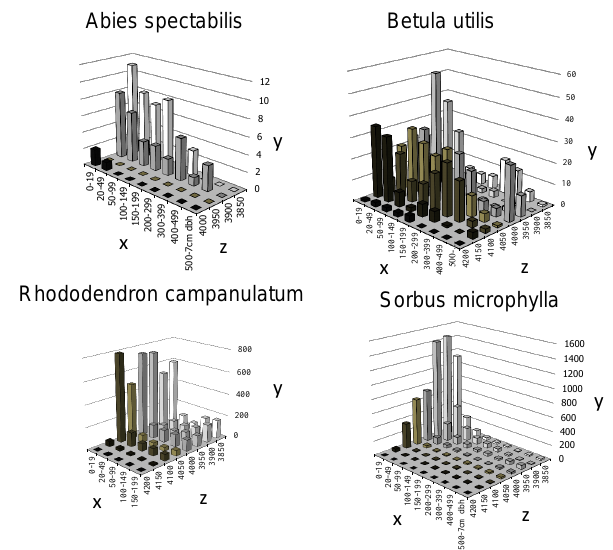
Figure 10. Seedling/sapling density in the treeline ecotone in Lang- tang Valley according to altitude and size classes ( x axis: size class; y axis: quantity; z axis: